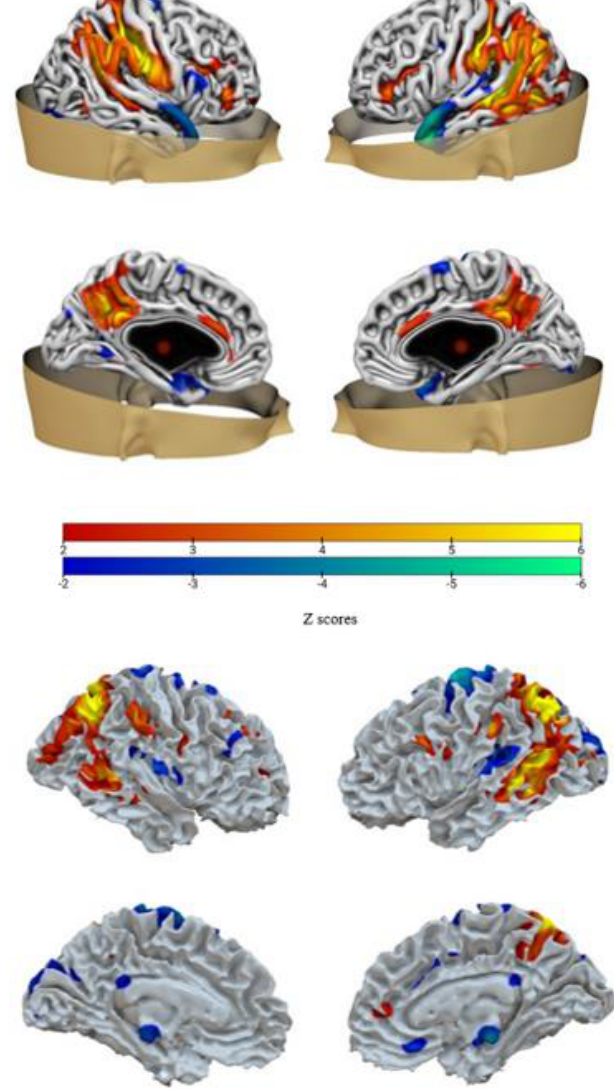
Figure 2. Network 1. Brain plot of IC-GM5 ( top ) and of IC-WM4 ( bottom ). Warm colors represent region with positive values, while cold colors represent regions with negative values.